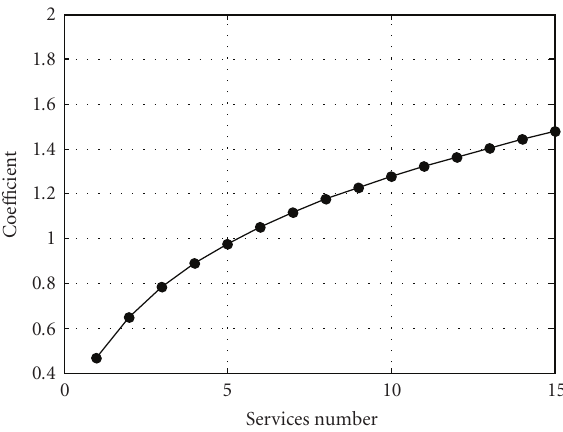
Figure 5: Service order e ff ect compensation